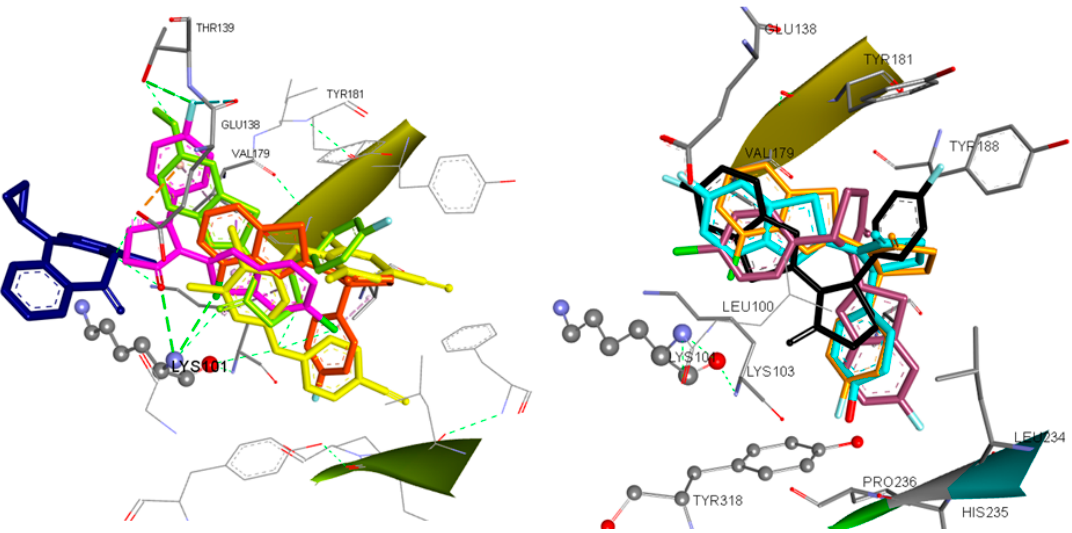
Figure 6. (Left) Docking of Etravirine (yellow), Nevirapine (blue) and Compounds 8 (magenta), 20 (light green) and 10 (orange) in the Binding Site of HIV-1RT. (Right) Docked Conformations of Compounds 3 (black), 5 (dark purple), 7 (light blue) and 10 (orange) in the Binding Site of HIV-1RT.